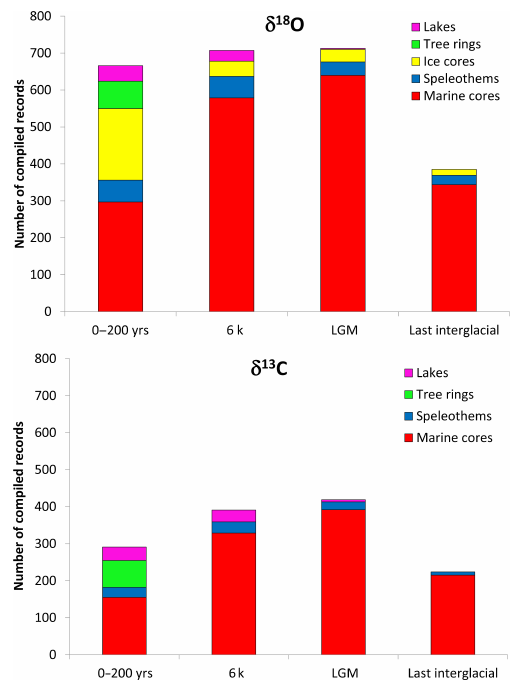
Figure 6. Diagrams showing the number of δ 18 O and δ 13 C records from marine and lake cores, speleothems, ice cores, and tree-ring cellulose for each PMIP time slice.